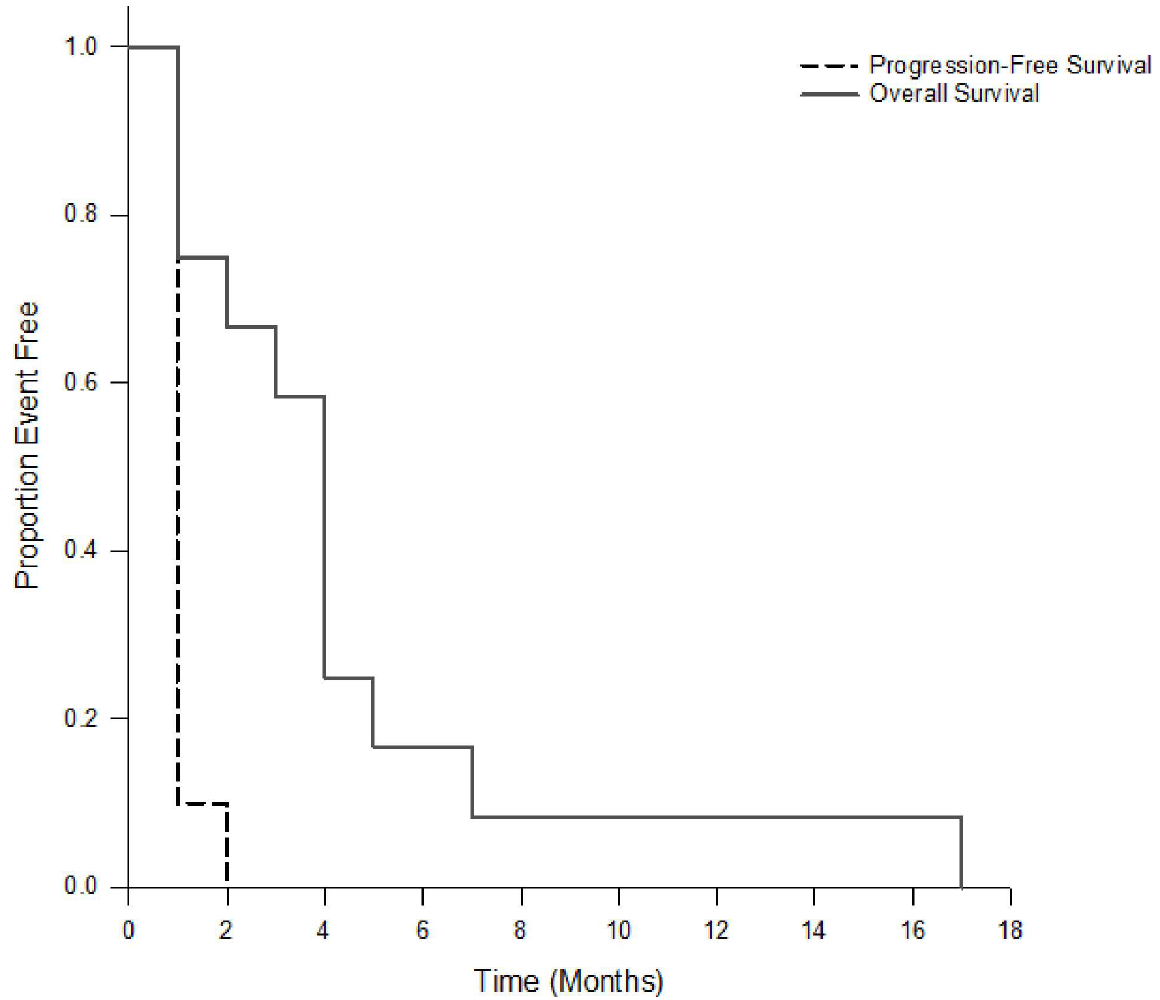
Fig 2. Kaplan-Meier curve of overall survival and progression-free